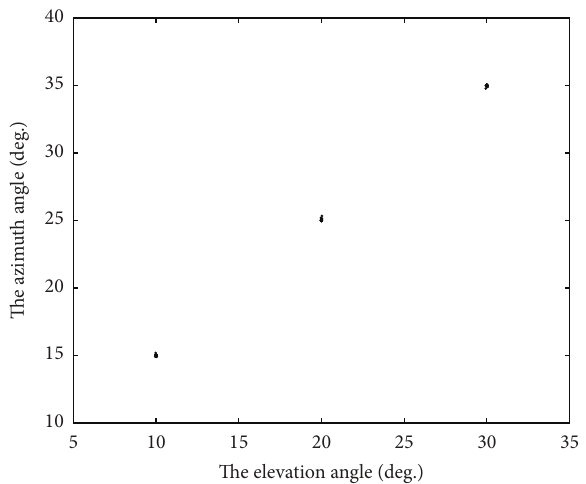
Figure 2: 2D DOA estimation via FPC-ROOT algorithm.